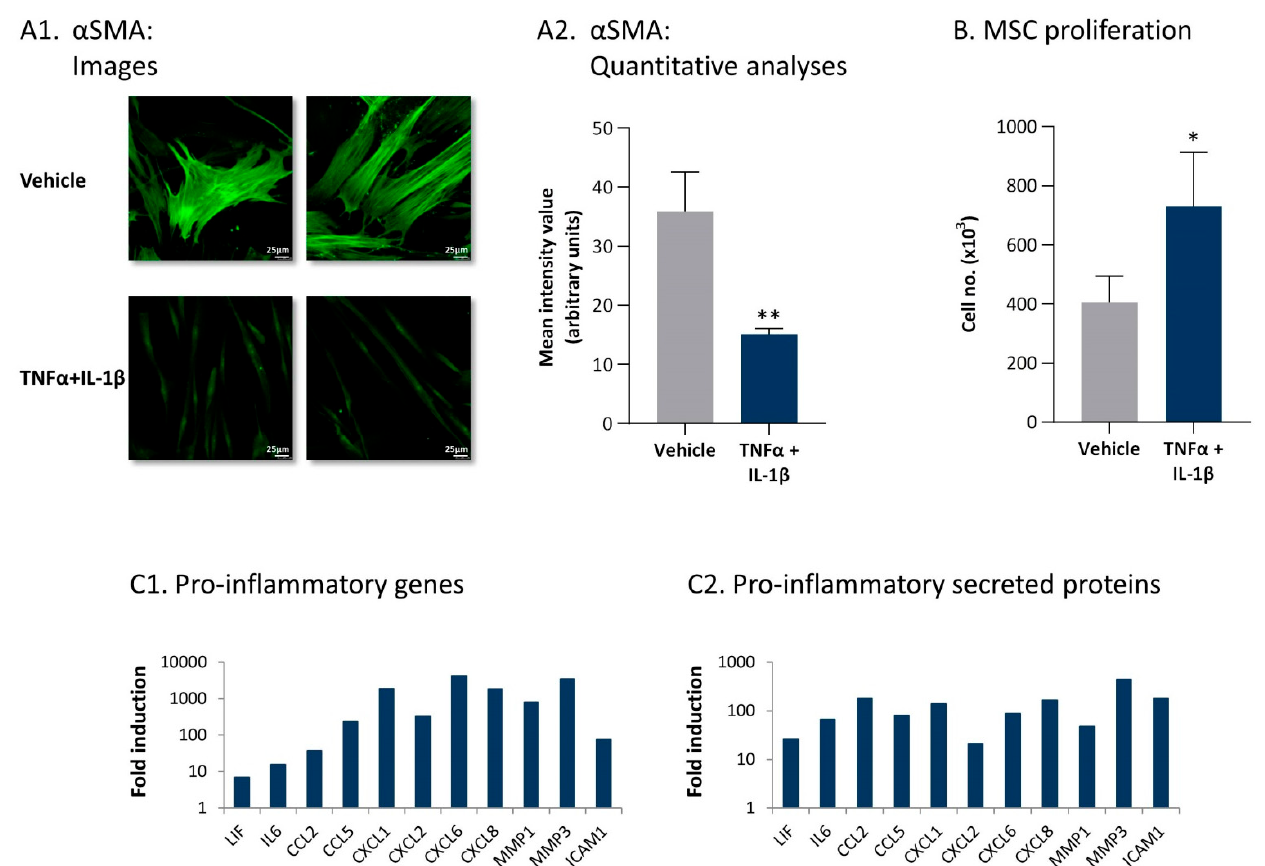
Figure 5. Persistent stimulation with TNF α + IL-1 β leads to the conversion of MSCs to inflammatory CAFs. ( A , B ) Human MSCs were exposed to persistent TNF α + IL-1 β stimulation (concentrations as in Figure 1) or to vehicles, generally for 14–18 days. ( A ) α SMA expression was determined by confocal analyses. ( A1 ) Two images of each treatment, derived from a representative experiment out of n > 3, are presented. Bar, 25 μ m. ( A2 ) Quantitative analyses of the fluorescence intensity performed by the ImageJ program on images of the representative experiment ( n ≥ 5 images for each treatment). ** p < 0.01. ( B ) Cell proliferation was determined by cell counts at the end of the stimulation process. Average ± SD of n > 3 is presented. * p < 0.05. Time-dependent analysis of MSC cell numbers along the stimulation process are demonstrated in Figure S2. ( C ) Expression of pro-inflammatory genes and secreted proteins, determined at the end of the stimulation process, is demonstrated. ( C1 ) mRNA expression was determined by transcriptome analyses performed at day 14, with three independent biological repeats. padj < 10 × 10 − 10 – padj < 5 × 10 − 271 , depending on the gene. ( C2 ) Expression of secreted proteins, determined by secretome analyses performed at days 18–19 with three independent biological repeats. p < 10 − 3 – p < 7.5 × 10 − 7 , depending on the protein. Data are presented as the fold induction of values obtained in cytokine-stimulated cells compared to vehicle-treated cells for all genes and proteins. Tables S1–S4 demonstrate the 60 top upregulated or downregulated genes and proteins, obtained following persistent stimulation of the MSCs by TNF α + IL-1 β .